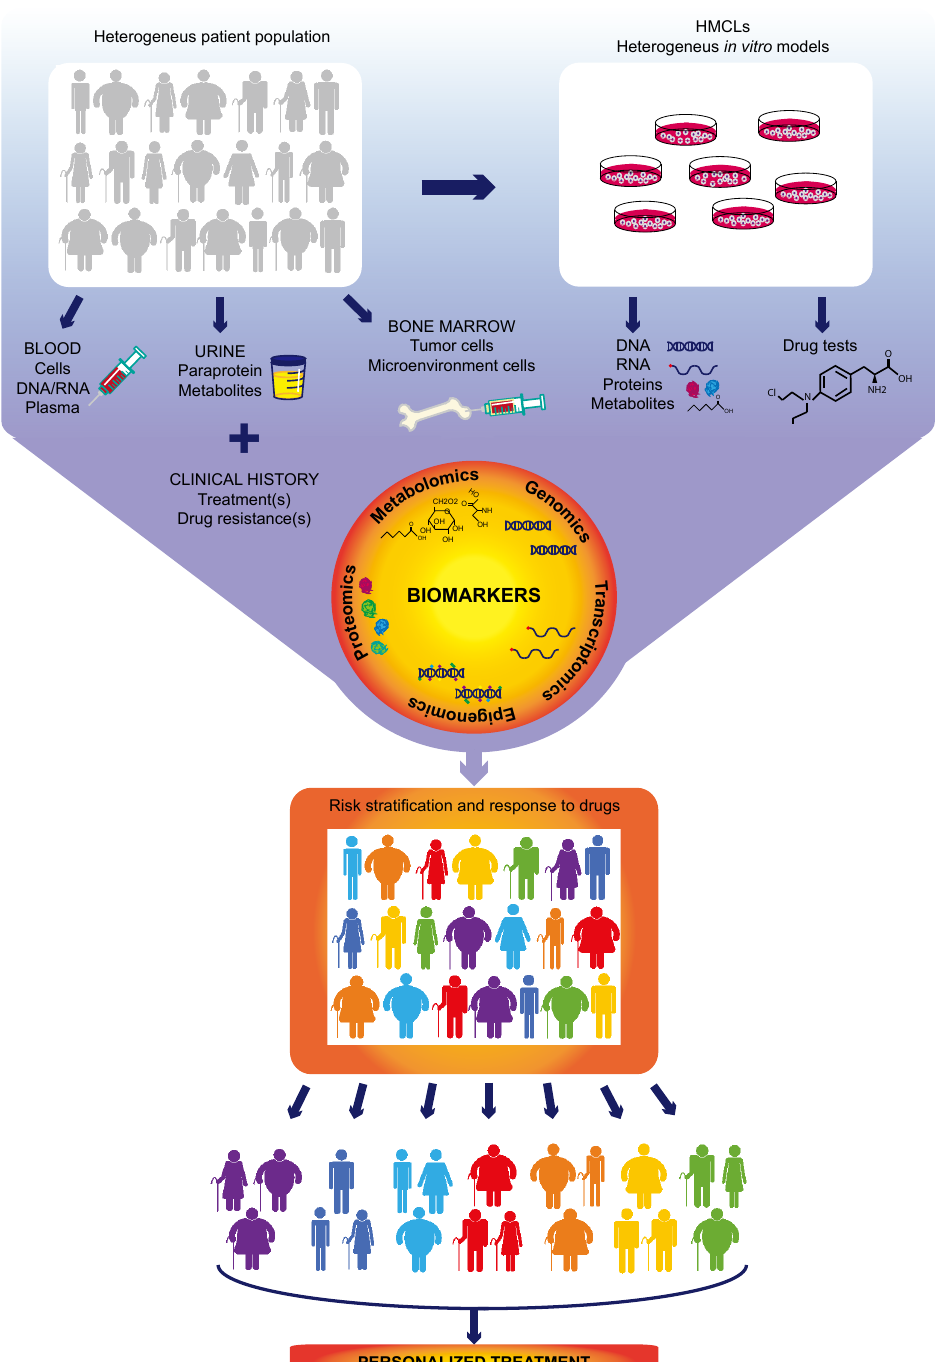
Figure 2. Omics approaches for the development of personalized treatments in MM. Cells and biological molecules are obtained from blood, urine and BM samples from heterogeneous populations of MM patients. HMCLs that reflect MM heterogeneity derived from patientsprovide a tool to study drug responses in vitro and are a source of biological molecules for subsequent studies. Analyses of patient and HMCLs samples by omics approaches lead to the identification of biomarkers that allowrisk stratification and predict response to